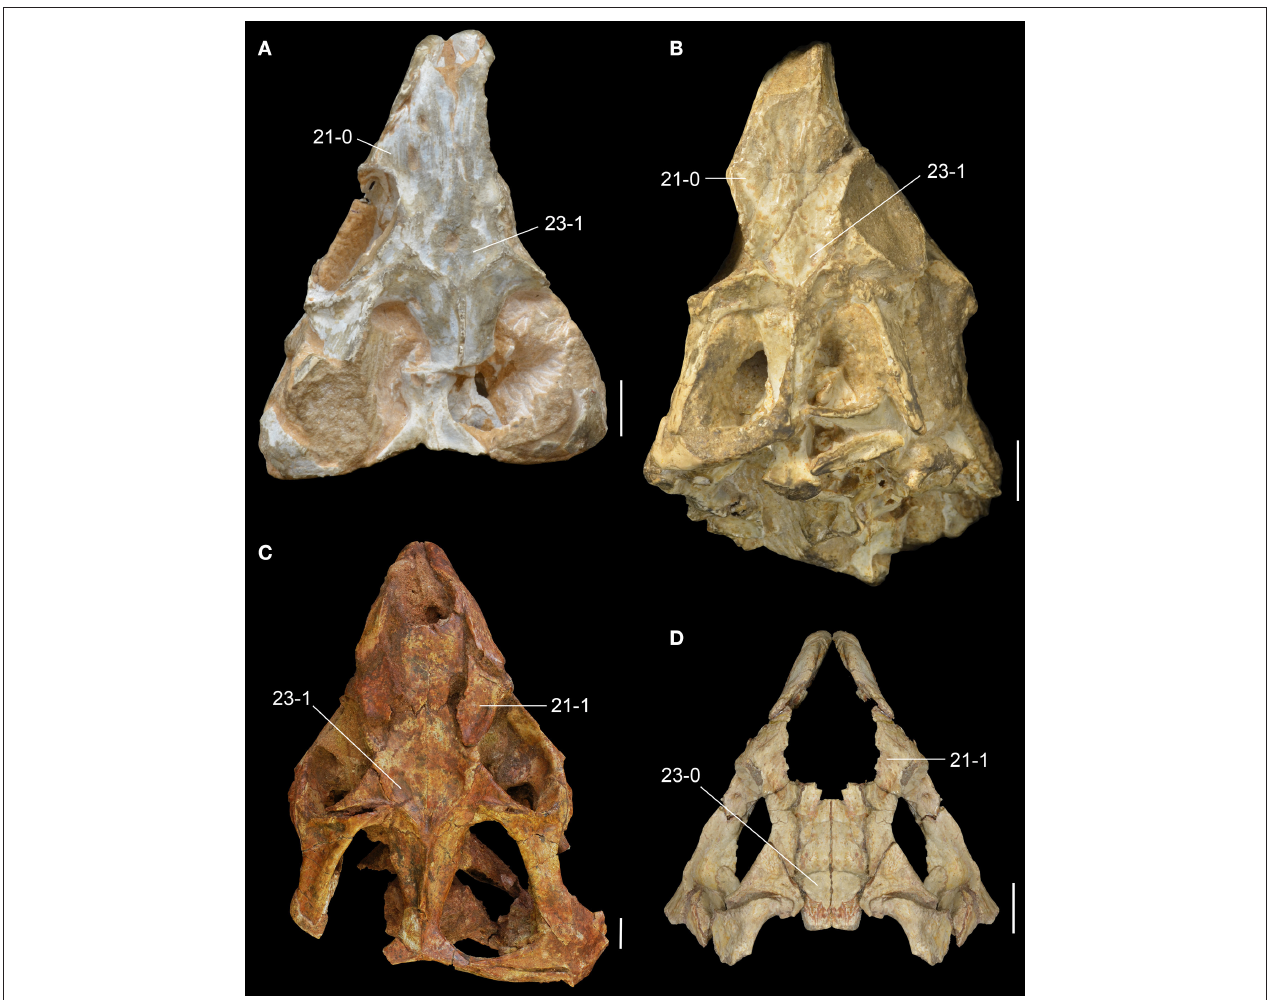
FIGURE 8 | Middle Triassic rhynchosaur skulls compared in dorsal view. Rhynchosaurus articeps ( A : NHMUK PV R1236; B : SHMYS 1, lectotype), Bentonyx sidensis ( C : BRSUG 27200, holotype), and Langeronyx brodiei ( D : WARMS G6097/1, holotype, right side mirrored from preserved left side). Numbers indicate character-states synapomorphic of L. brodiei and rhynchosaurids to the exclusion of stenaulorhynchines and R. articeps . Scale bars equal